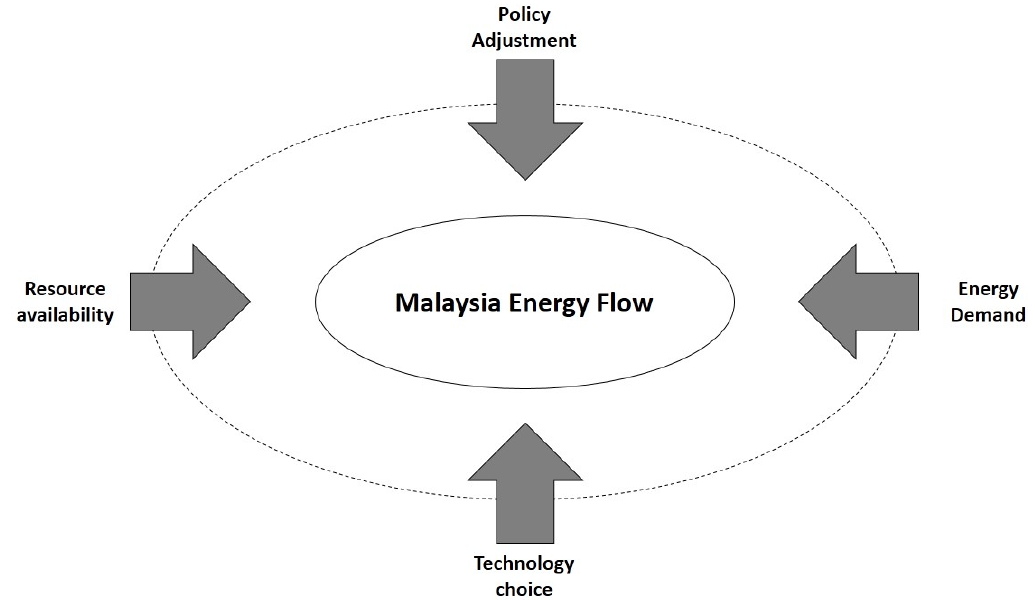
Figure 1. The framework of the system